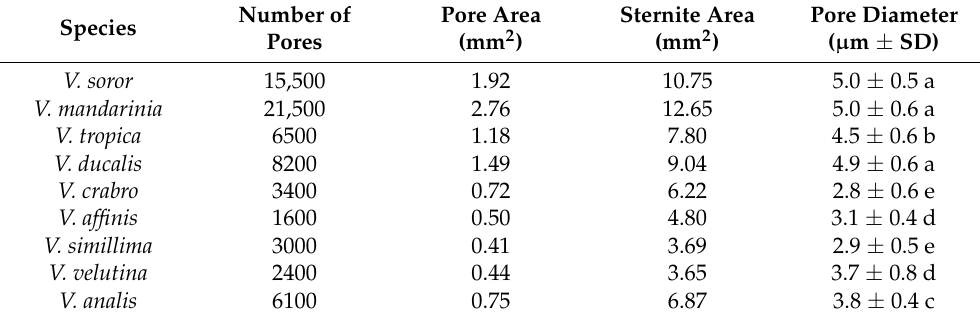
Table 3. Size of features associated with the Richards gland for nine Vespa species. Species are presented in the order in which they appear in the phylogeny depicted in Figure 1. Sternite area extends from the anterior cuticle margin to posterior margin where the smooth cuticle ends (see Figure S1). All estimates were pooled across images of specimens within species. Different letters indicate significant differences among species in pore diameter. Pore number for each species was rounded to the closest hundred. Number of Pore Area Sternite Area Pore Diameter Species Pores (mm 2 ) (mm 2 ) ( µ m ±